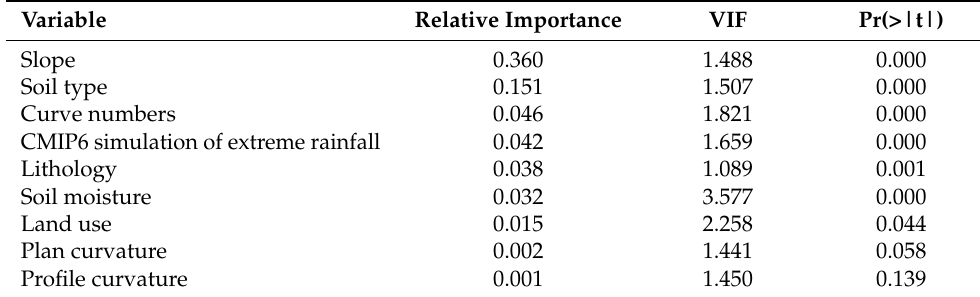
Table 3. Results of multicollinearity